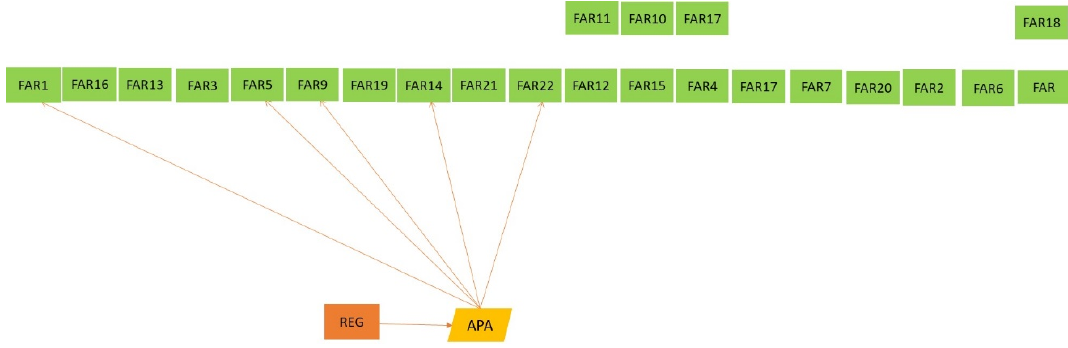
Figure 5. Food network detected in 2018: the funding flow between the region (REG), livestock association (APA), and the farms (FARn). Source: own data.